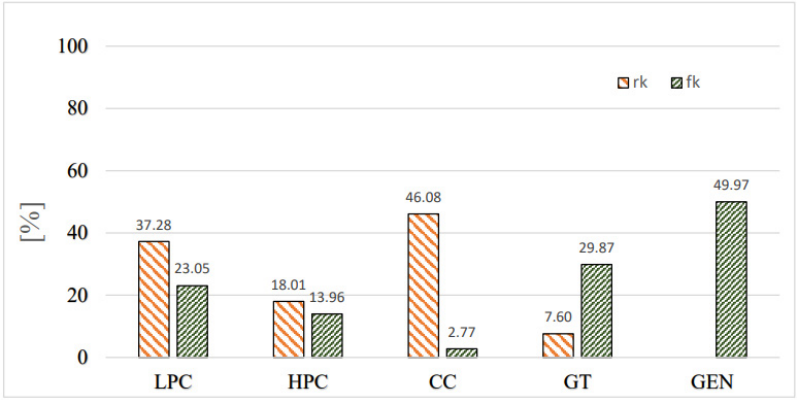
Figure 5. Exergoeconomic factor ( 𝑓 𝑘 ) and relative difference in cost ( 𝑟 𝑘 ) for main components of the gas- turbine engine (Two-Stage centrifugal compressor).